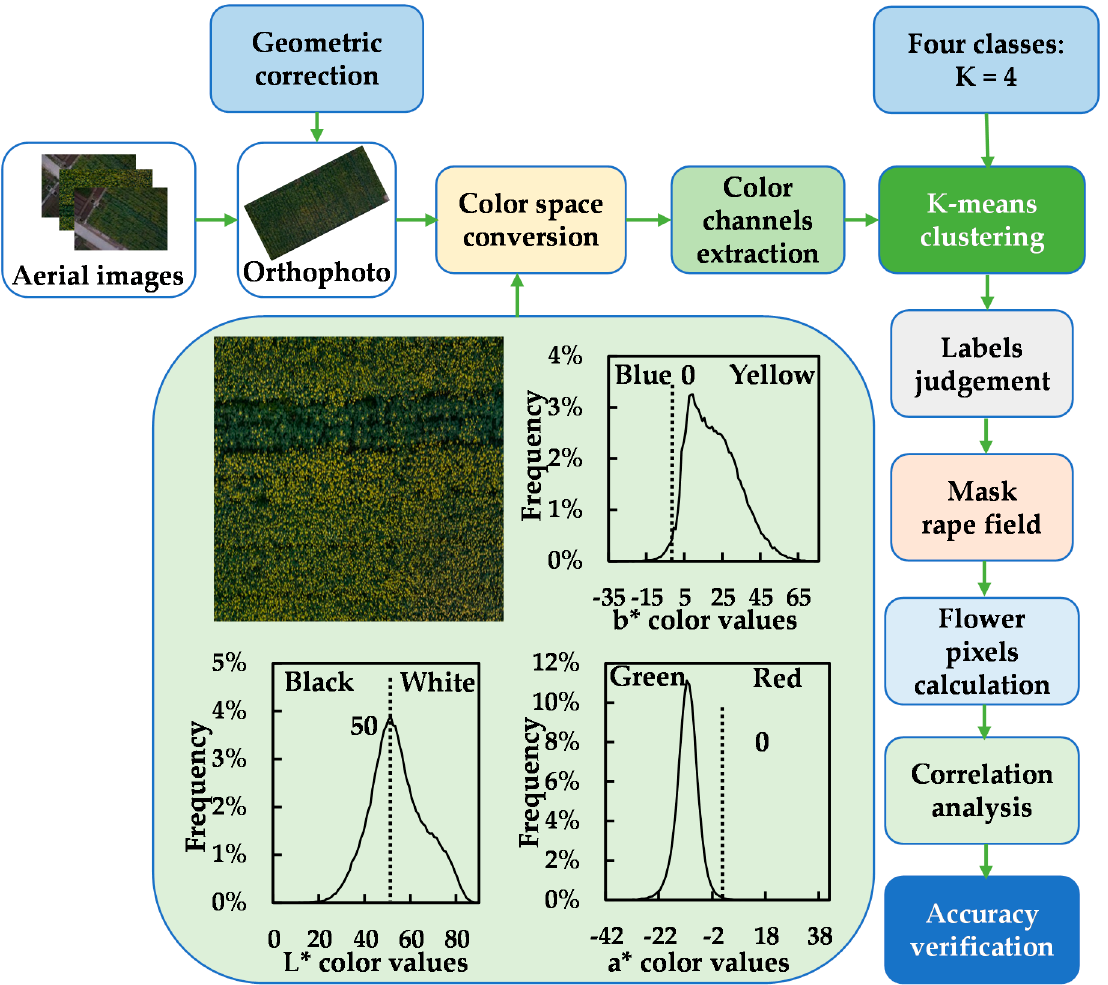
Figure 2. Flowchart of image classification of yellow flowers in the rape field by K-means clustering algorithm by CIE L*a*b* space.